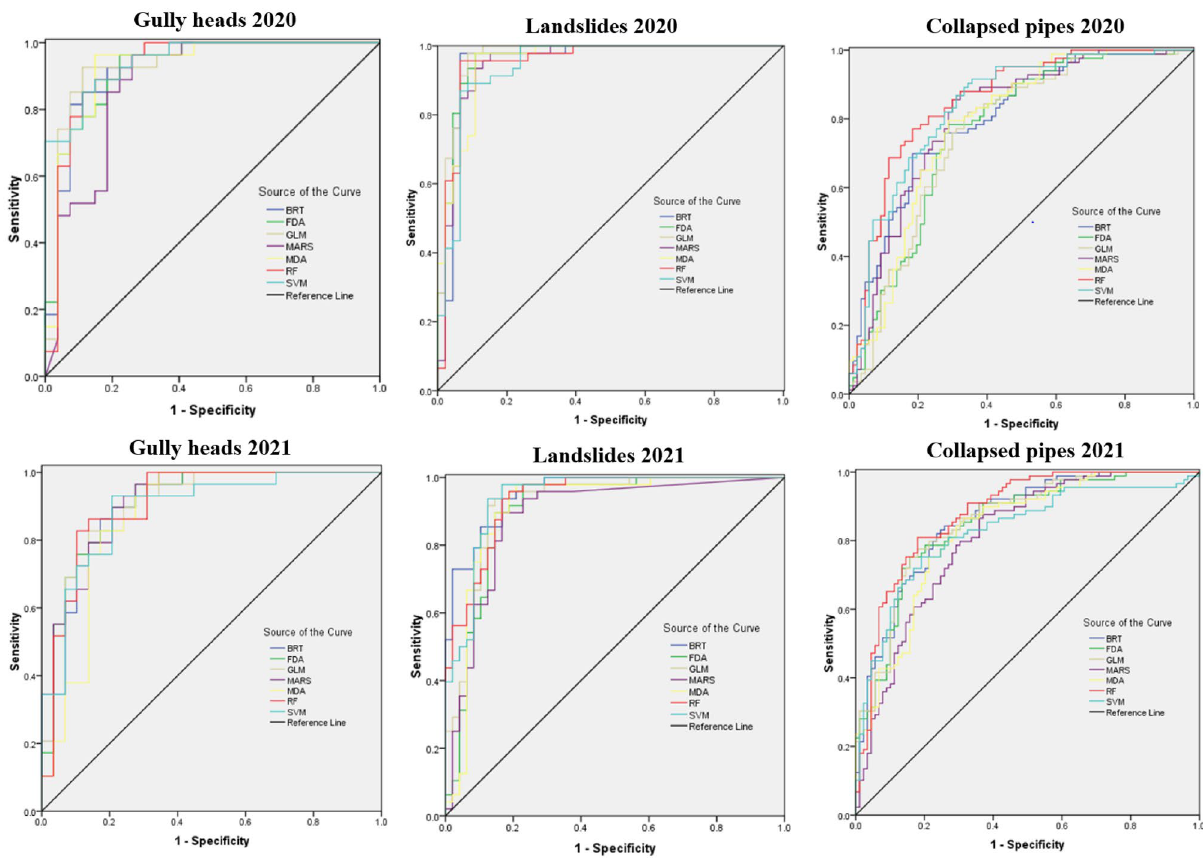
Figure 5. ROC curves for the seven models in the training step. Area under the